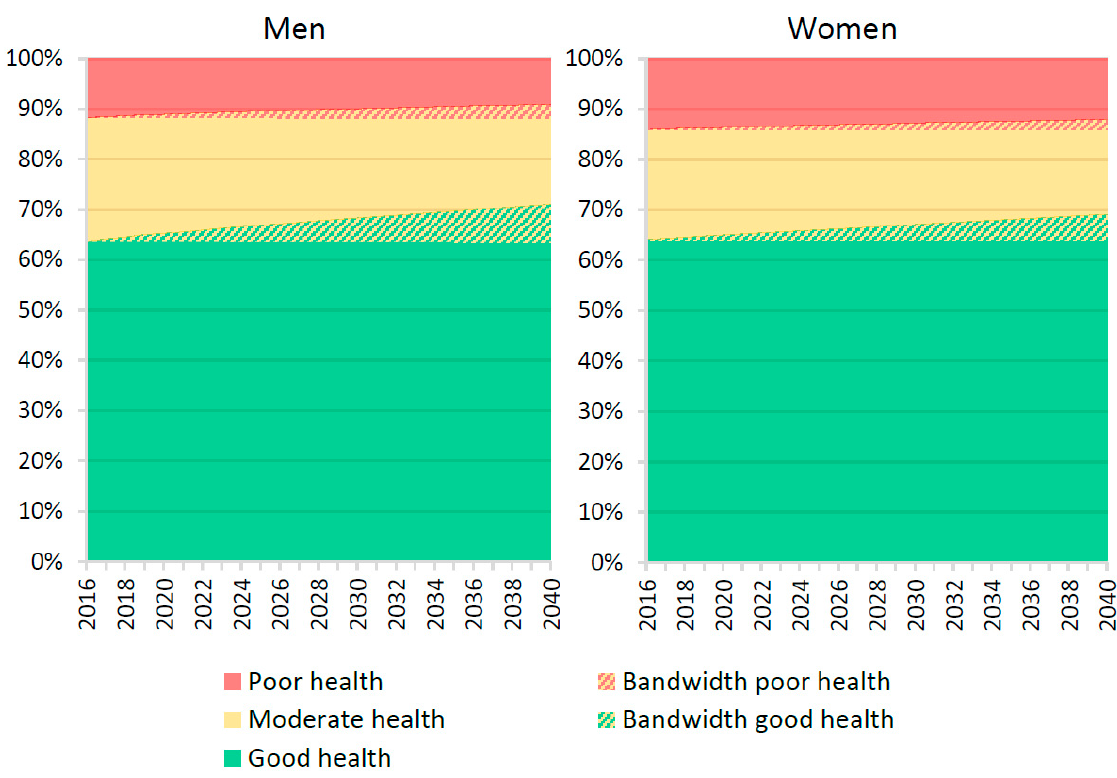
Figure 2. Projections in health for persons over 60 years of age up until the state pension age according to two scenarios (2016–2040).